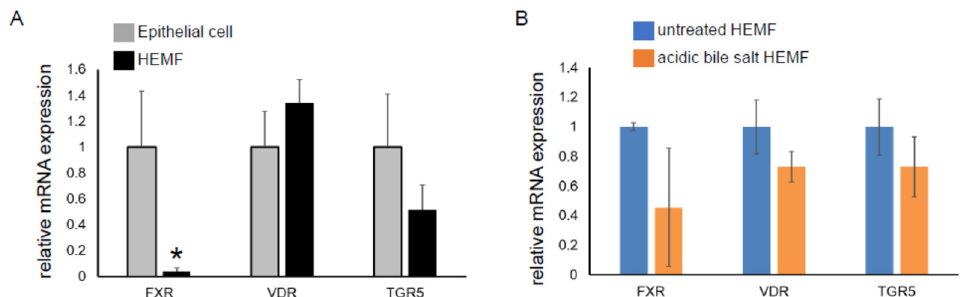
Figure 4. mRNA expression of bile acid receptors in a squamous epithelial cell line and in a HEMF cell line. mRNA expression of bile acid receptors TGR5, VDR, and FXR were evaluated in ( A ) untreated epithelial cells and HEMFs and in ( B ) untreated vs. acidic-bile-salt-treated HEMFs. Statistically significant differences are shown by * symbol with p value ≤ 0.05. Results shown represent the means ± SEM of three independent experiments conducted with a HEMF cell line and with an esophageal epithelial cell